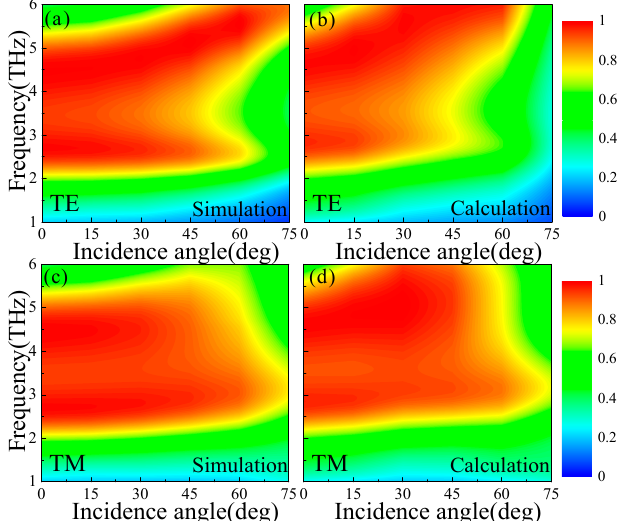
Figure 5. The ( a , c ) simulated and ( b , d ) calculated absorbance of MMAs under di ff erent oblique incidence angles for ( a , b ) TE and ( c , d ) TM waves ( E f = 0.8